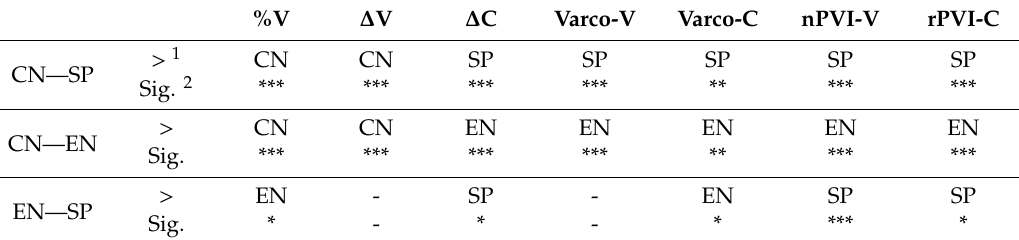
Table 4. Significance results with LME for Chinese, Spanish, and